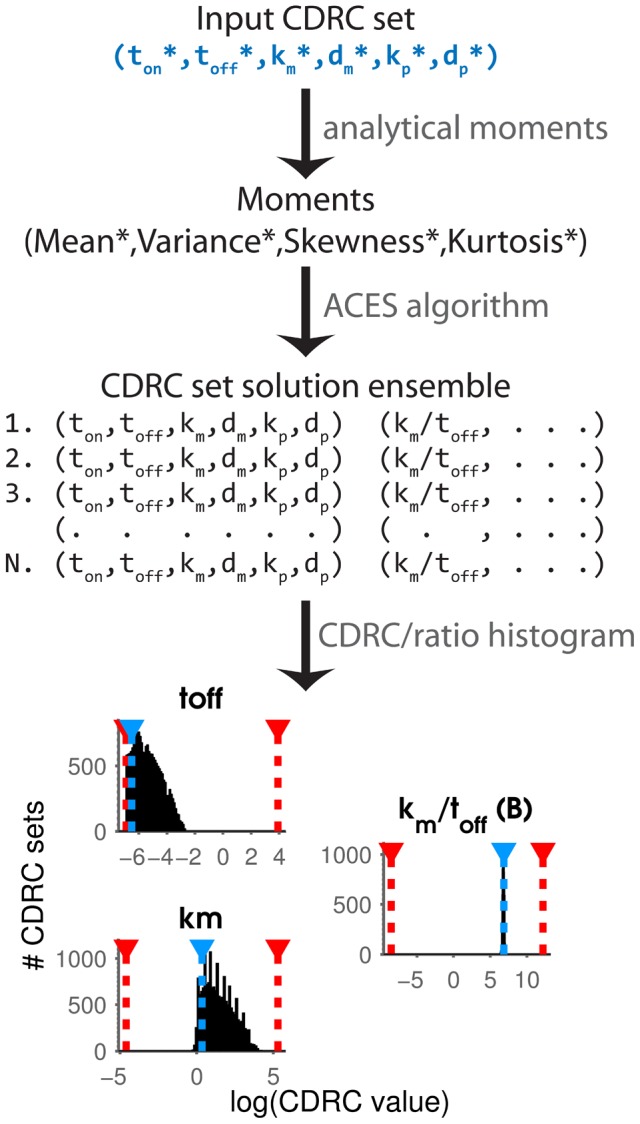
CDRC estimation pipeline.At the top, a library member input CDRC set (blue,*) is used to compute its corresponding moments (*). ACES takes as input only the moments, and returns all CDRC sets that correspond to those moments (the “ensemble”). To visualize this result, a histogram is generated for each CDRC or ratio column-wise. In the resulting histograms, physiological range of the parameter (red, dashed), the input value (blue dashed), and the ensemble solution values (black) are plotted for the tested parameter space (x-axis). On the bottom left, histograms for the CDRCs  and  span half their physiological range, but their ratio is constrained to a single value (right, burst size).